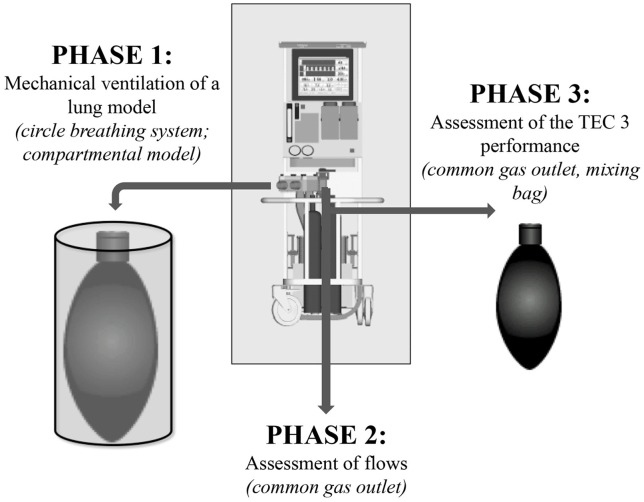
Steps of investigation of the manual or computer-driven flowmeters' different performance on isoflurane changes in Tafonius.